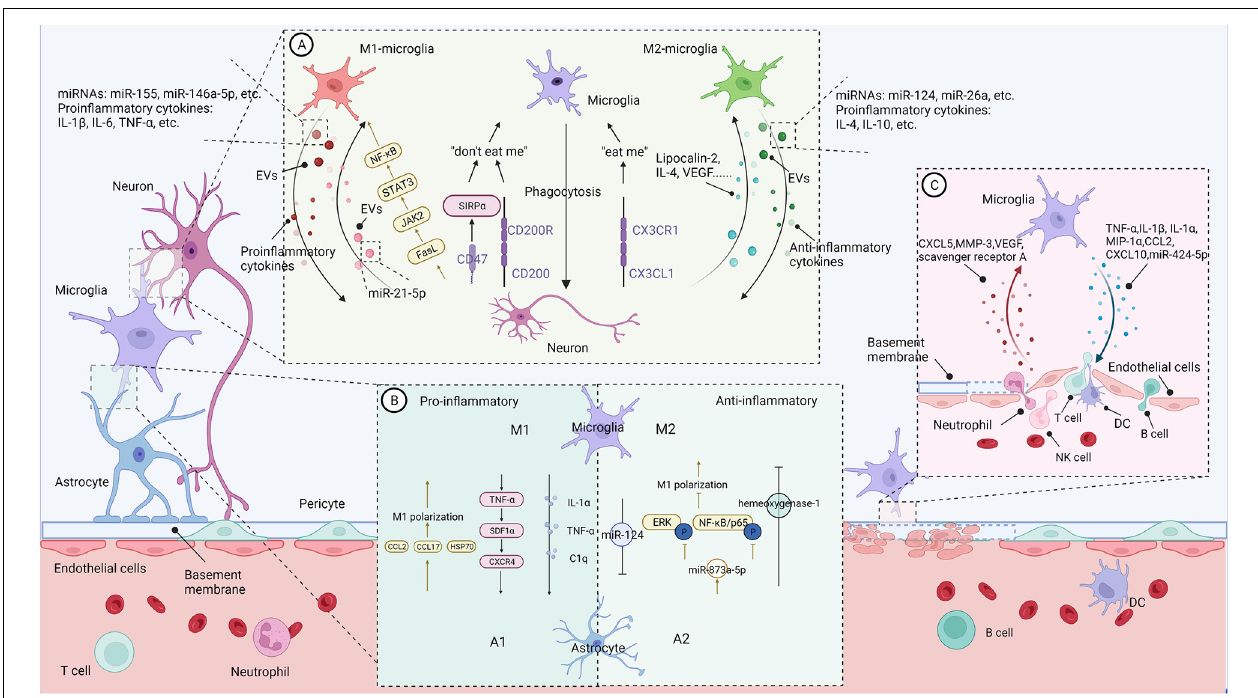
FIGURE 1 | The communication between microglia and CNS-resident cells in the context of neuroinflammation (Figure created with BioRender.com). (A) Bidirectional microglia-neurons communication. Activated microglia generally perform phagocytosis to limit secondary neuronal damage caused by apoptotic or stressed neurons. Neurons release “eat me” or “don’t eat me” signals to modulate microglia’s phagocytosis. In addition, activated microglia increase the shedding of EVs containing pro- or anti-inflammatory cytokines and miRNAs, promoting or suppressing neural destruction. On the contrary, damaged neurons regulate microglial action and polarization through different signals. (B) Bidirectional microglia-astrocytes communication. Microglia with different phenotypes can modulate phenotypic transformation, proliferation, and glial scar formation of astrocytes through pro-inflammatory or anti-inflammatory signals. Similarly, astrocytes regulate microglial phenotypes and functions through their secreted molecules. (C) Bidirectional microglia-microvascular endothelial cells communication. Interactions between activated microglia and the endothelial cells of the BBB increase the permeability of the blood-brain barrier and promote leukocyte infiltration. In contrast, bidirectional communication between microglia and peripheral immune cells enhances central nervous system inflammation and promotes disease